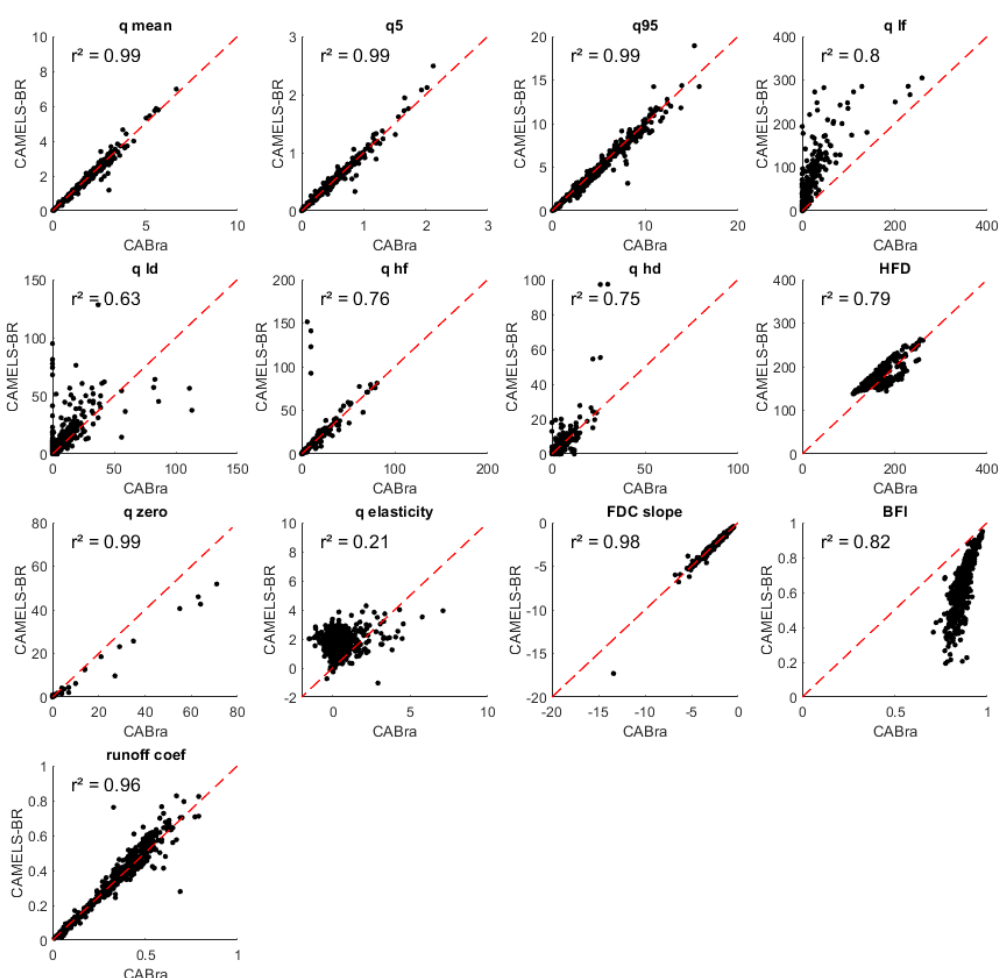
Figure 15. Scatter plots and correlation coefficients between hydrological signatures of CABra and CAMELS-BR catchments. There were 607 catchments and 13 hydrological signatures that overlapped in both